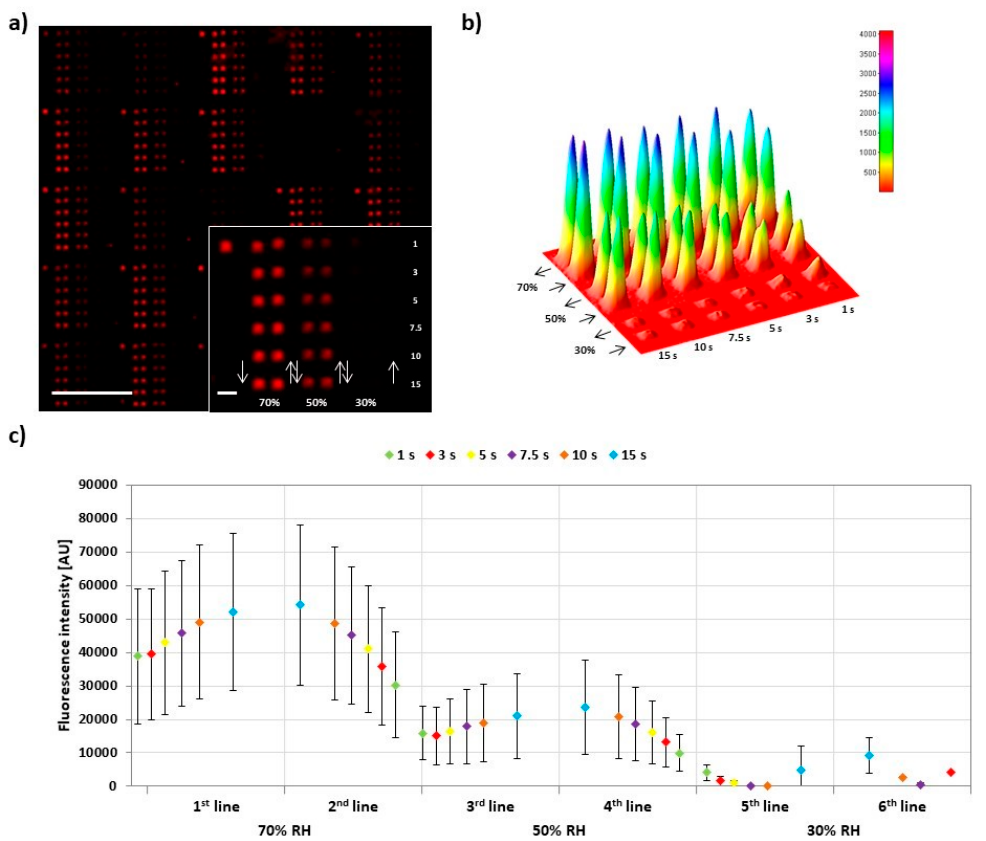
Figure 5. Combined effect of dwell time and humidity on lipid ink transfer. ( a ) Representative fluorescence micrograph of the printed 6 × 6 arrays designed to analyze the amount of transferred lipid in dependence of relative humidity and dwell time. The inset shows higher magnification of a single array along with the printing scheme. The scale bars equal 100 µm in the main image and 10 µm in the inset; ( b ) Three-dimensional plot of the intensity profile of the single array from the inset in panel ( a ); ( c ) Plot of the average intensity of corresponding spots (same line, same RH and same dwell time) in 30 analyzed arrays against the dwell time and grouped by RH. Error bars represent standard deviation.